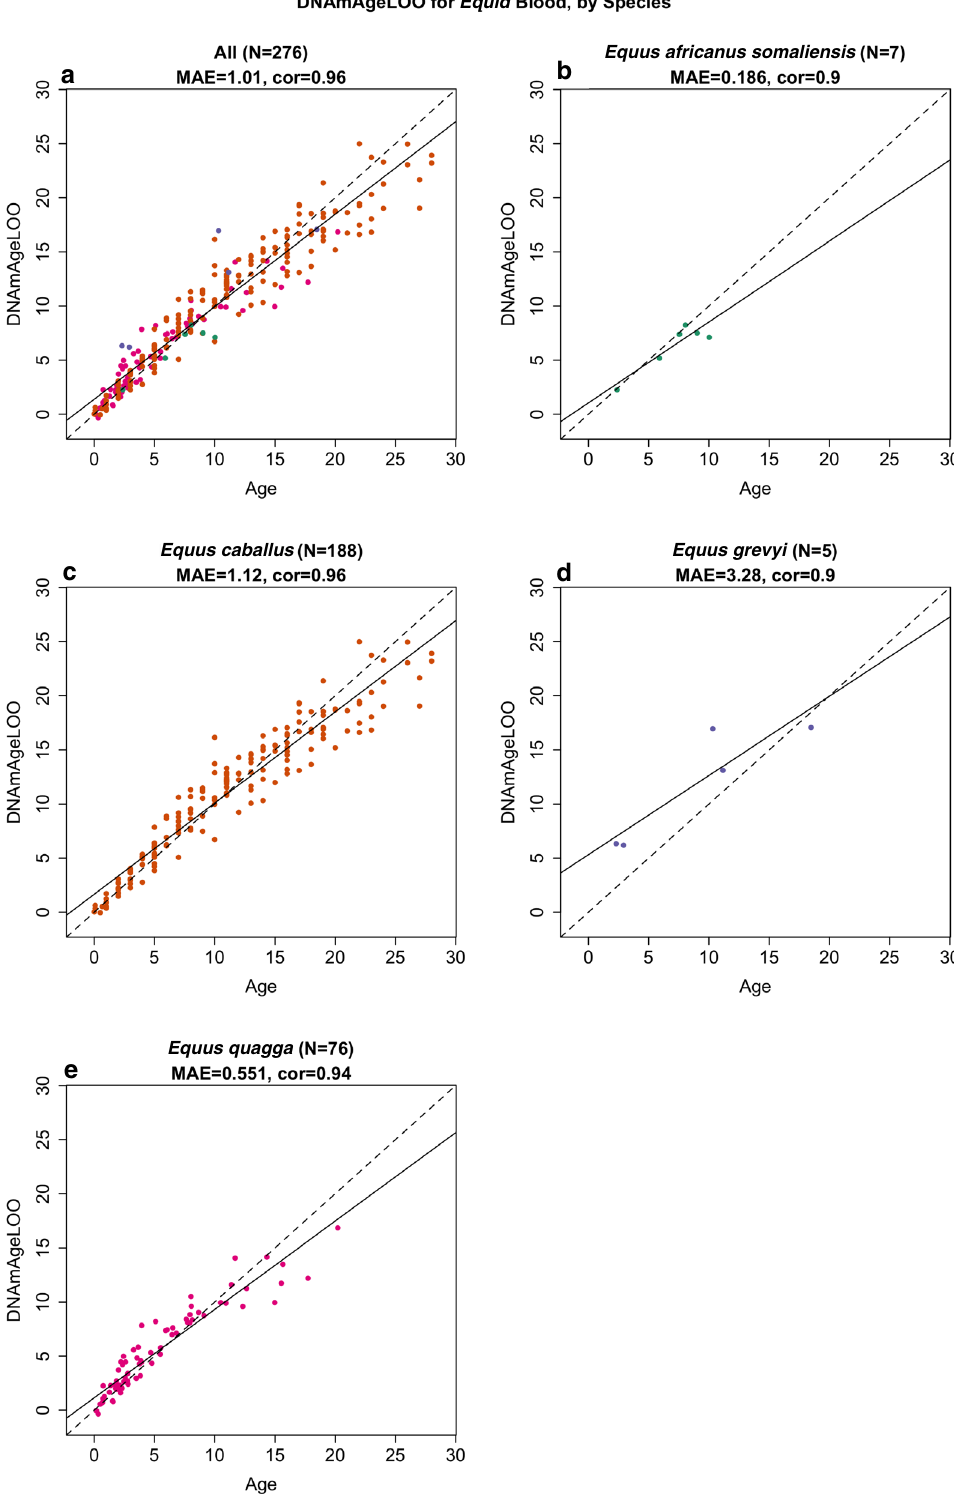
Fig. 2 The equid clock for blood samples. Blood samples (dots) are colored by species as indicated in the respective panels. Leave one sample out cross- validation estimate of age ( y -axis) versus chronological age in a all species combined, b Equus africanus somaliensis , c Equus caballus , d Equus grevyi , e Equus quagga . Each panel reports the number of blood samples, median absolute error in units of years, and Pearson correlation.